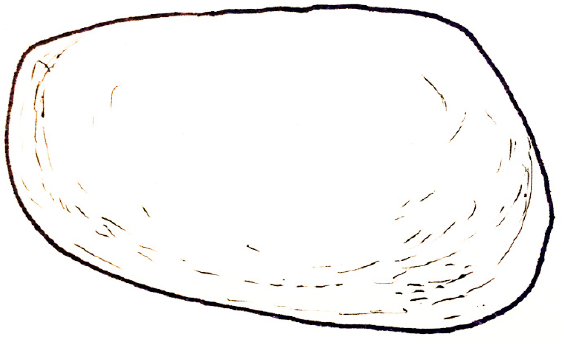
Figure 17. Indiana lentiformis . Anterior to left. Length of shield 13.3 mm. Image Credit: Mark McMenamin.